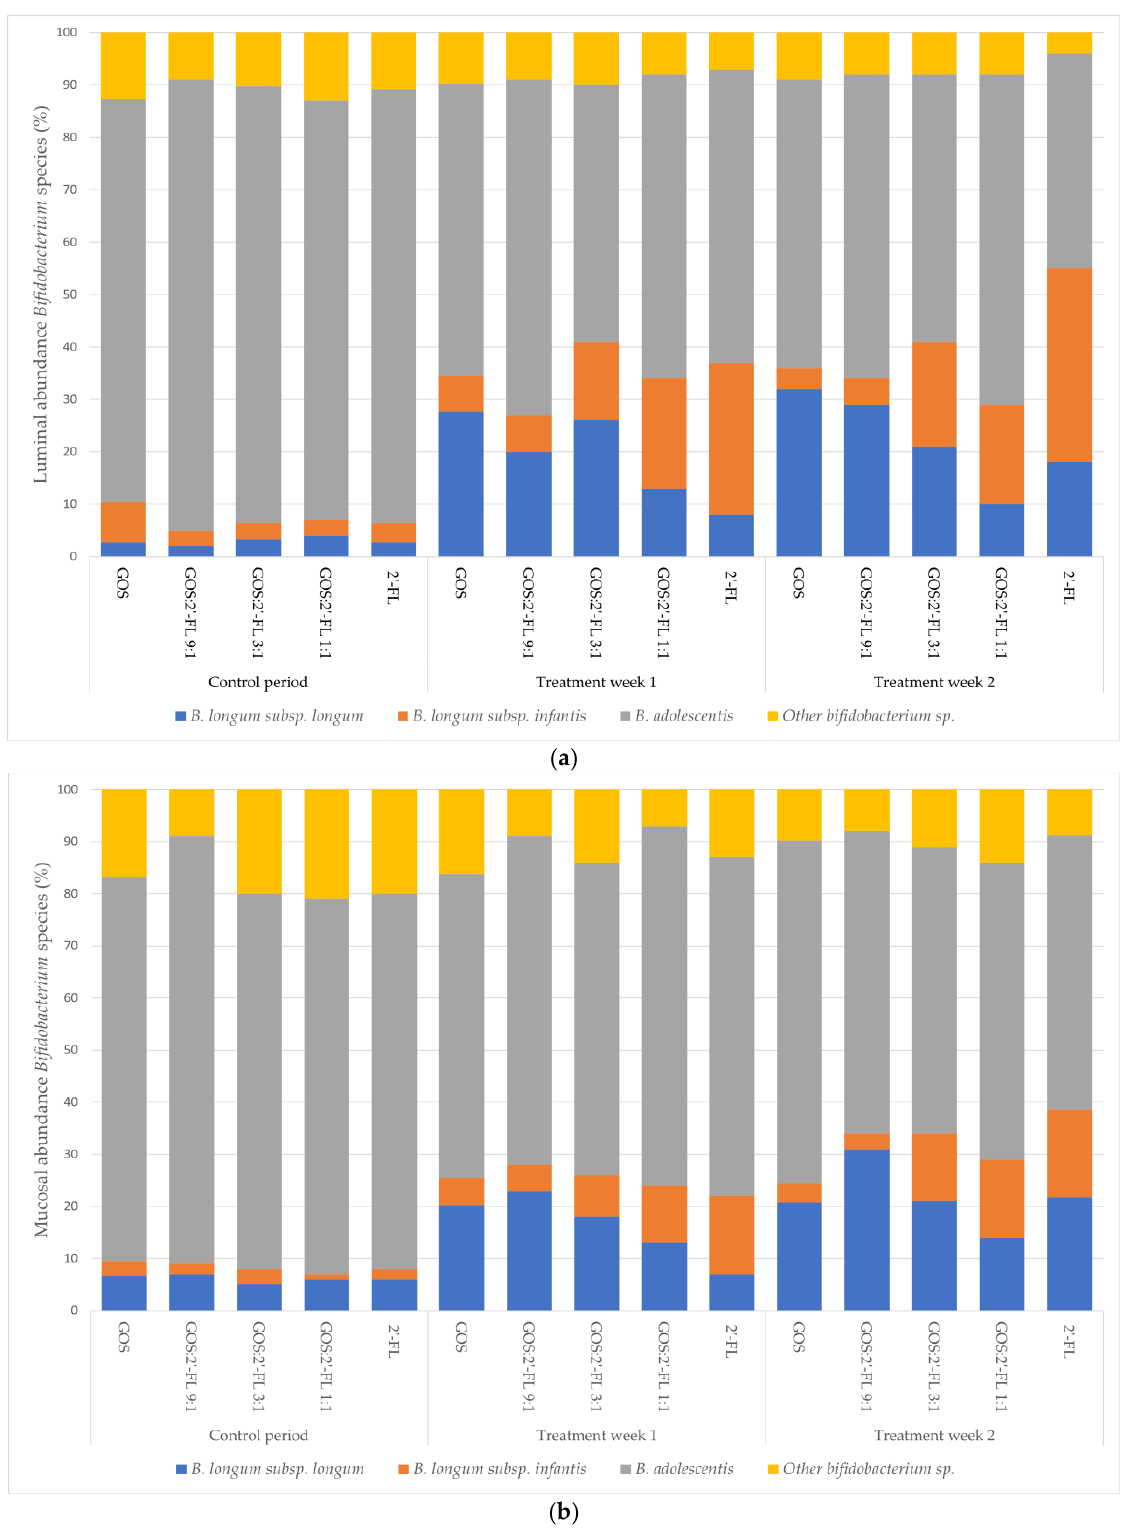
Figure 5. Relative share of three Bifidobacterium (sub)species in the luminal ( a ) and mucosal ( b ) microbiota in the proximal colon of the baby M-SHIME ® during the control and treatment phases (first week, TR1; second week, TR2), with different combinations of GOS and 2′ -FL, as identified by DGGE.